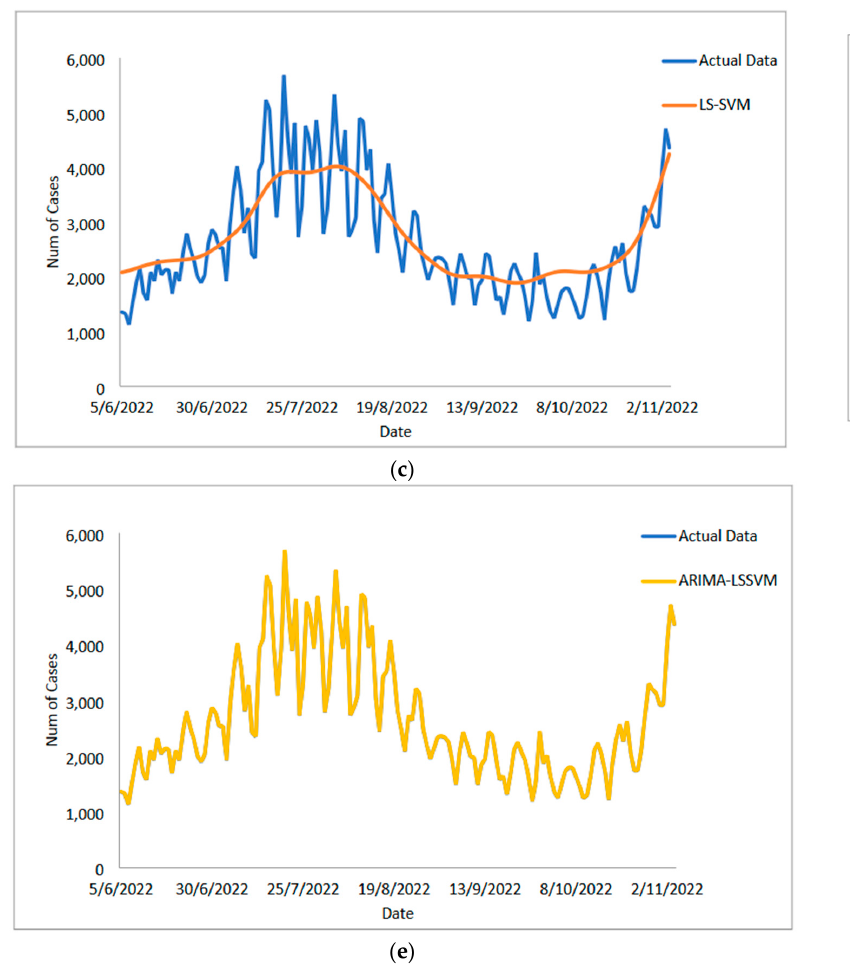
Figure 4. Models’ prediction of daily new positive COVID-19 cases dataset (20% test sample): ( a ) actual data vs ARIMA model, ( b ) actual data vs SVM model, ( c ) actual data vs LSSVM models, ( d ) actual data vs ARIMA–SVM models, ( e ) actual data vs ARIMA–LSSVM models.